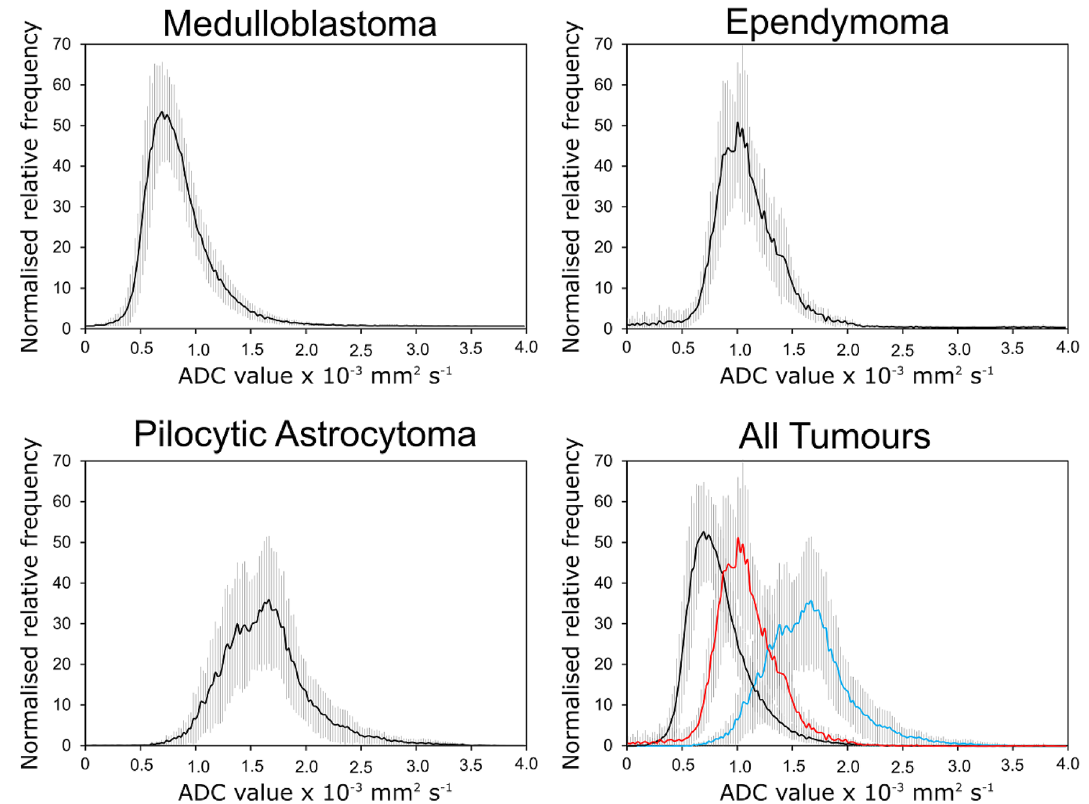
Figure 3. Mean normalised histograms for the most common paediatric posterior fossa brain tumours. The shaded areas show the standard deviation. The bottom right shows histograms for the different tumour types overlaid with the black representing Medulloblastomas, red representing Ependymoma sand blue representing Pilocytic